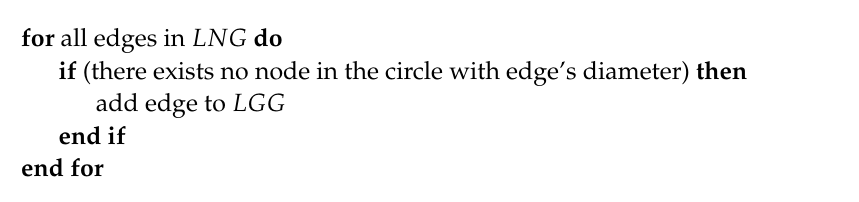
Algorithm 1 Generating the GG edge list from the edge list of a local network graph. LNG : edge list of the local network